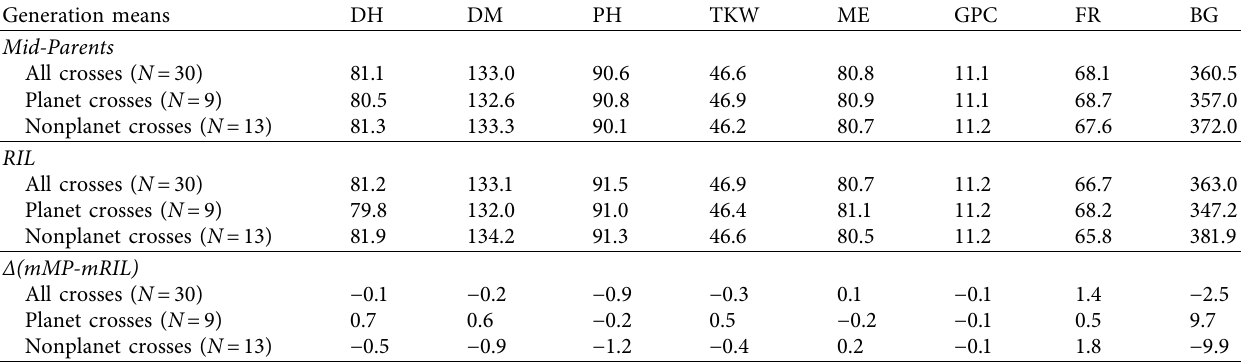
Table 11: Comparison of generation means of mid-parent values ( μ MPV) and derived recombinant inbred lines ( μ RIL) estimated across two